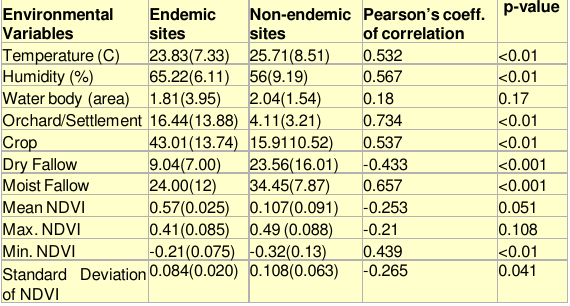
Table 2: Statistical analysis of endemic and non-endemic area